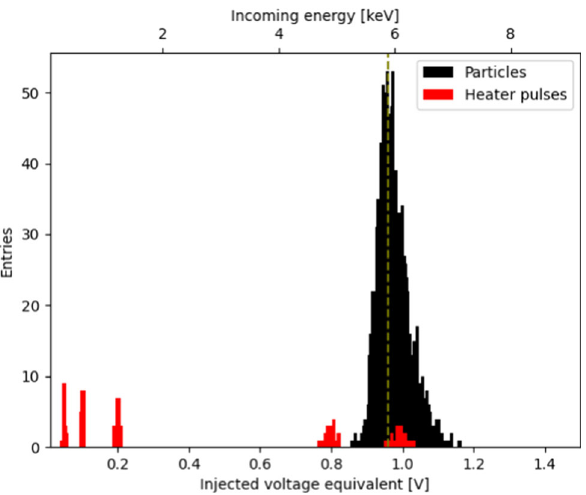
Fig. 2 Eventscomingfromtheironsource(black)intheenergyregion 5.2 keV–7 keV and events coming from the artificial pulses sent by a heater (red) in the calibration data set for module number 1 (duration 17.7